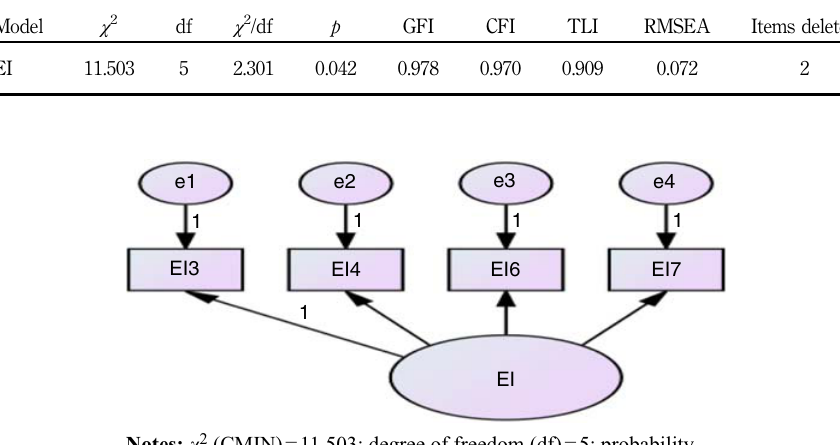
Figure 5. Measurement model